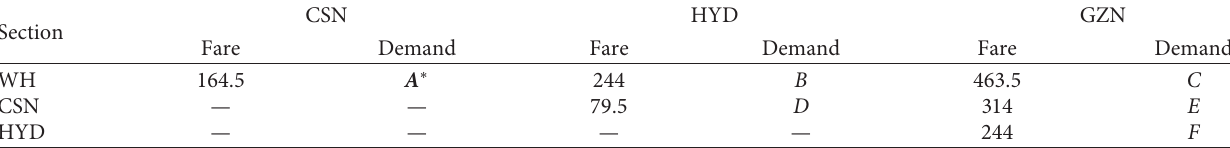
Table 2: The labels and fares of the major OD sections in WH-GZN